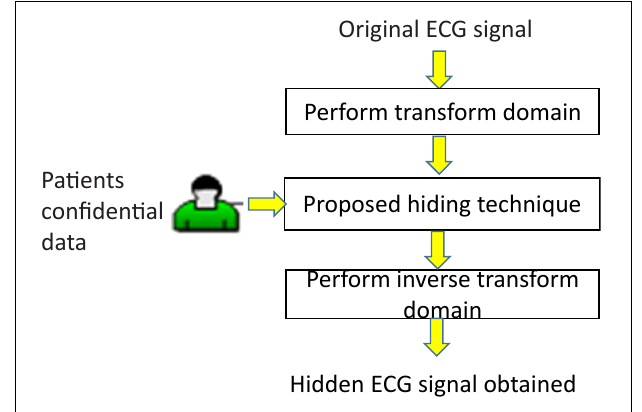
FIGURE 2 | A flowchart of the proposed